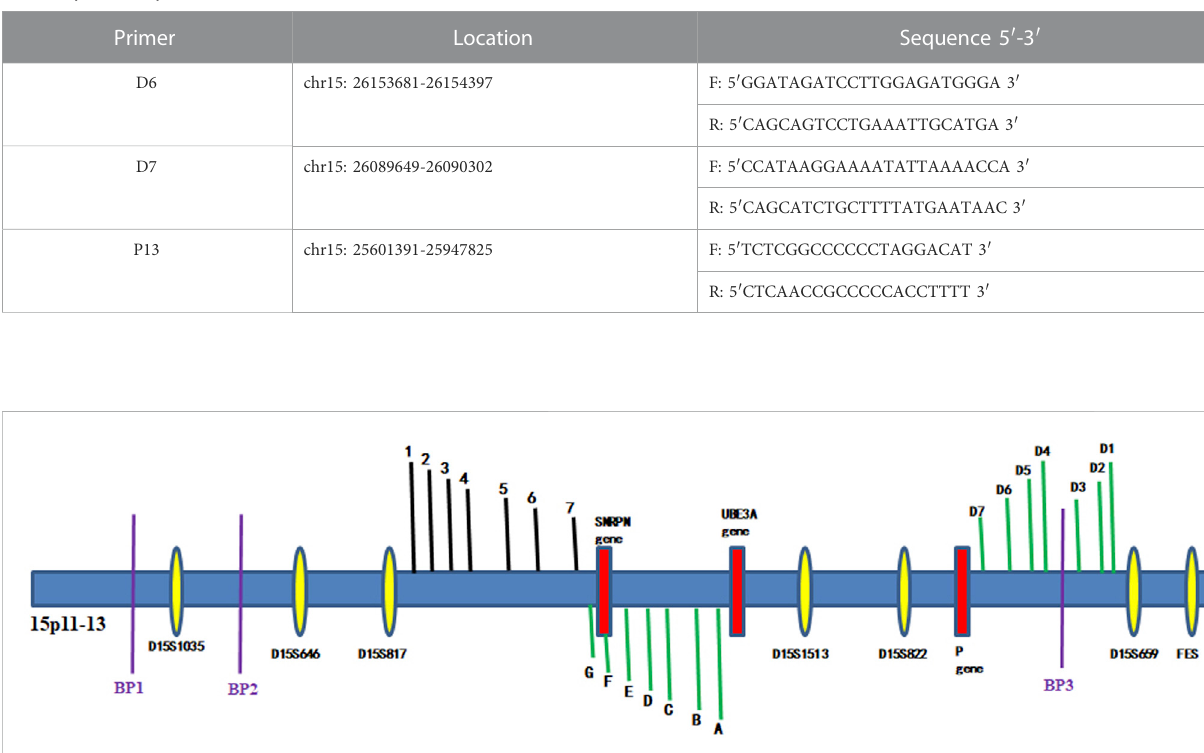
FIGURE 3 Haplotype schematic map of the members of family 1. The arrow indicates proband 1. She was affected by OCA2 with PWS due to an atypical deletion (chr15: 22330347 – 26089649, approximately 3.8 Mb) on paternal chromosome 15 and a point mutation c.1327G > A (Val443Ile) in the p gene of maternal chromosome 15.